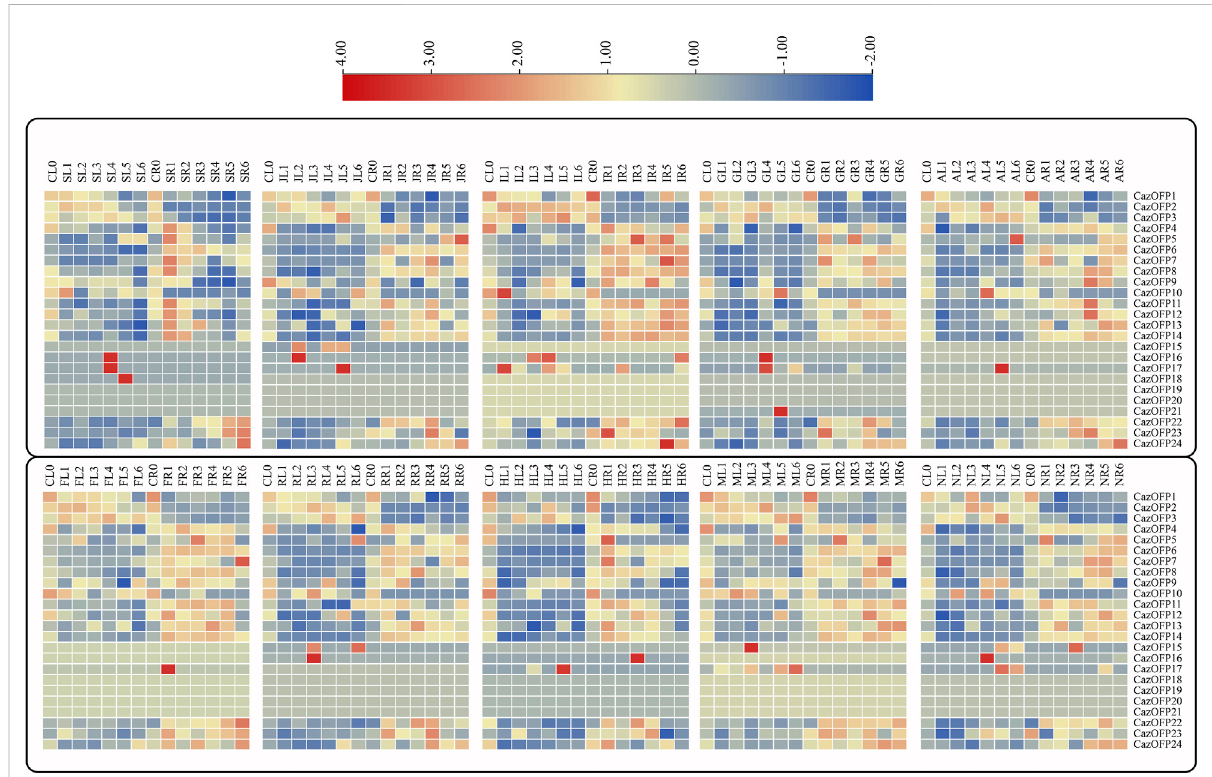
FIGURE 7 Analysis of CazOFP gene expression pro fi les in pepper. Red: up-regulated expression; Gray: not expressive; Blue: down-regulated expression. CL: Control Leaf; SL: SA Leaf; JL:JA Leaf; IL: IAA Leaf; GL: GA3 Leaf; CR: Control Root; SR:SA Root; JR: JA Root; IR: IAA Root; GR: GA3 Root; AL: ABA Leaf;FL:ColdLeaf;RL:H2O2Leaf;HL:HeatLeaf;ML:MannitolLeaf;NL:NaClLeaf;AR:ABARoot;FR:ColdRoot;RR:H2O2Root;HR:HeatRoot;MR: Mannitol Root; NR: NaCl